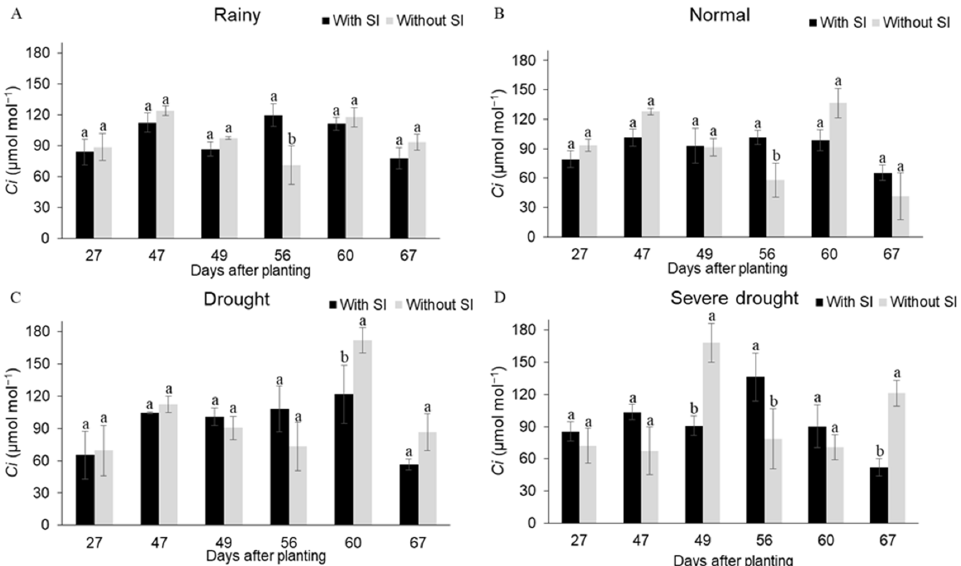
Figure 6. Internal CO 2 concentration of maize leaves under Rainy ( A ), Normal ( B ), Drought ( C ) and Severe drought ( D ) scenarios, showing sampling date and presence or absence of supplemental irrigation (SI) with brackish water (ECw = 4.5 dS m − 1 ). For each sampling date, means followed by the same letters do not differ ( p ≥ 0.05) from each other according to the Tukey test. Error bars represent the standard error of the mean ( n =